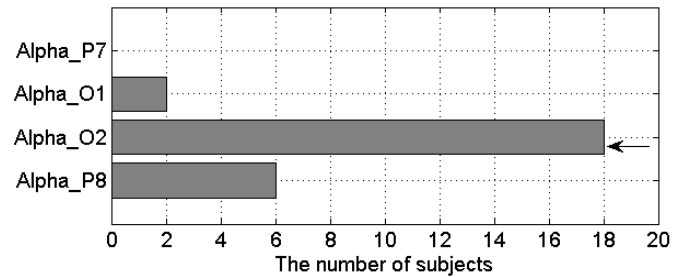
Figure 13. The bar graphs show the number of subjects that show positive linear relationship between ECD and α power percentage in each occipital channel. The arrow indicates the best occipital channel. The Y -axis indicates the EEG features (Alpha_P7— Per = u ( x, P7, α )). The X -axis indicates the number of subjects that exhibit an increasing α power percentage as the ECD